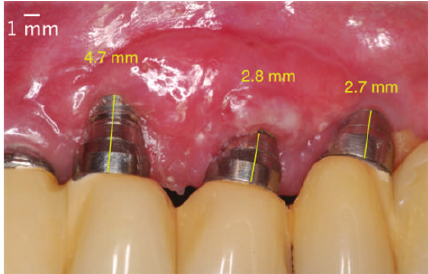
Figure 6: Postoperative aspect 21 days after surgery: the exposure of threads in the element 23 still exists.